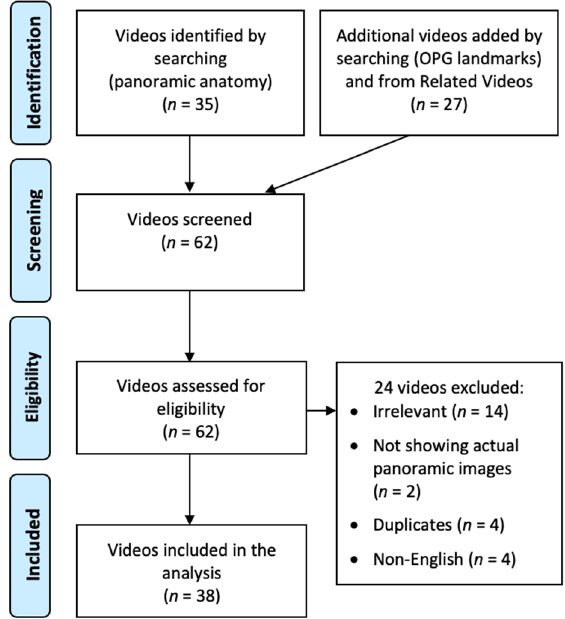
Figure 1. A flow chart showing the screening process of YouTube videos on panoramic anatomy. The number of views, likes, channel subscriber, and comments were recorded, as well as the video duration, age of video, and number of anatomical landmarks covered.